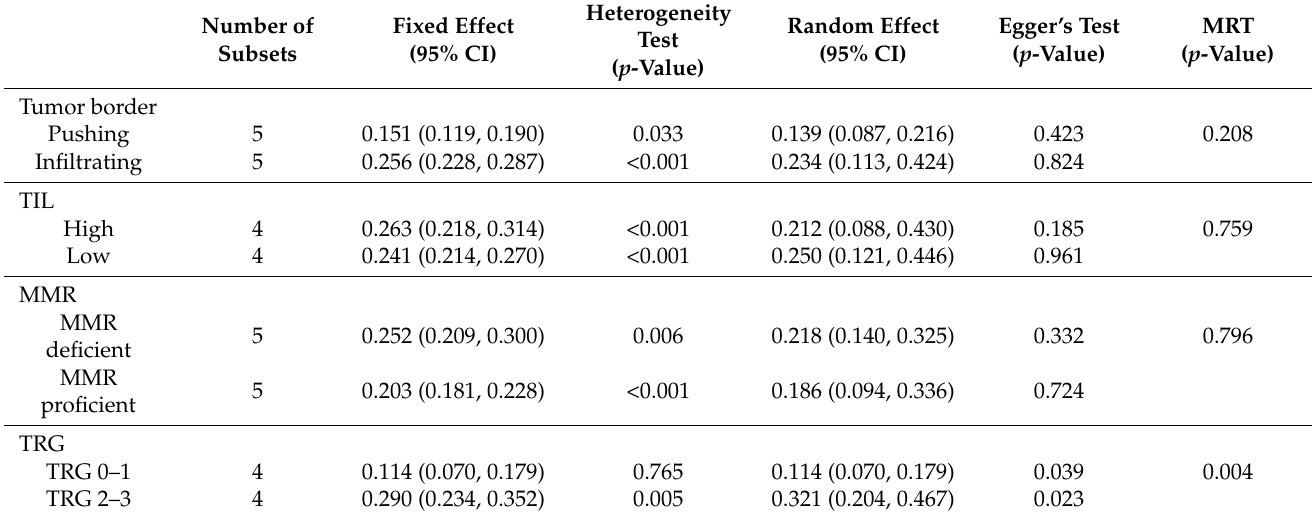
Table 4. The estimated rates of intratumor budding in colorectal cancers with various conditions.